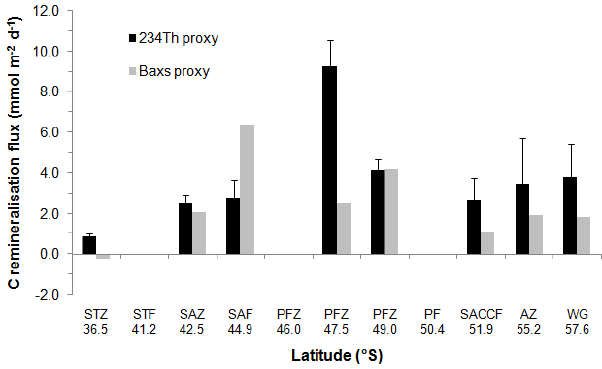
Fig. 10. Remineralisation flux of POC (mmolm − 2 d − 1 ) in mesopelagic waters from the 234 Th and Ba xs